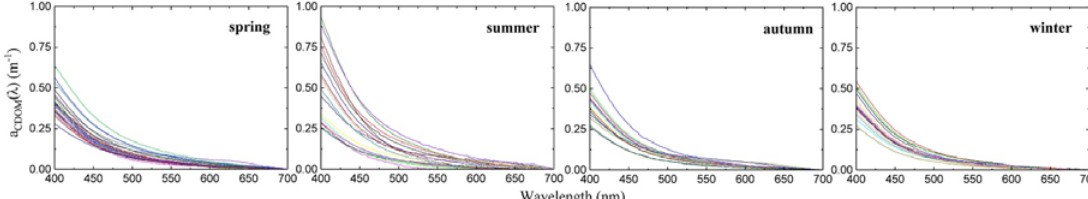
Figure 6. Seasonal variation of the CDOM absorption spectra. The different colored lines in each panel represent different sampling sites.